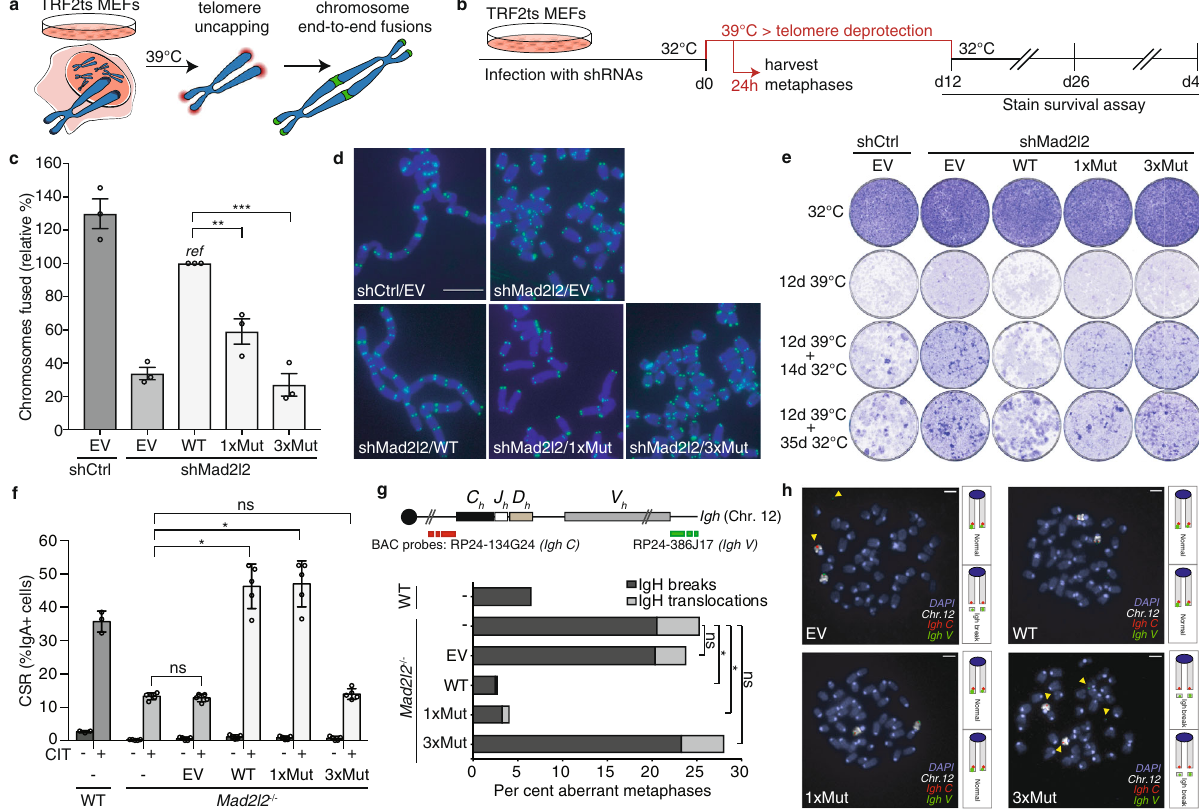
Fig. 2 MAD2L2 dimerization is needed for MAD2L2-mediated control of NHEJ at deprotected telomeres and MAD2L2-mediated class switch recombination. a Experimental approach to address telomere deprotection induced NHEJ. b Schematic overview of the experimental setup used in c – e. c Chromosomal fusions in TRF2ts MEFs transduced with indicated shRNAs and expression constructs ( n = 3 independent experiments, mean ± s.e.m., a minimum of 1500 chromosomes were counted per condition, per experiment). One-way ANOVA with Dunnett ’ s multiple comparisons test (** p = 0.0046; *** p = 0.0002). d Representative images of metaphases counted in c . Scale bar, 10 μ m. e Survival assay of TRF2ts MEFs used in c – d Cells were cultured at 32 °C to exclude toxicity of the infected cells, or at 39 °C for 12 days to induce telomere deprotection. Cells were returned to 32 °C for the indicated times, and stained to assess survival. Plates are representative of n = 2 independent biological duplicates, the second biological duplicate is shown in Supplementary Fig. 1e, f. f CSR defect in Mad2l2 − / − cells is rescued after complementation with WT MAD2L2 and 1xMut but not with 3xMut. Bars represent mean ± s.e.m., two-sided Wilcoxon – Mann – Whitney test. n = 3 independent experiments with one WT clone and two Mad2l2 − / − clones, ns p = 0.6752 (-vs. EV) and p = 0.8340 (-vs. 3xMut); * p = 0.0119. CIT: anti-CD40, IL-4 and TGF- β . g Quanti fi cation of Igh breaks and translocations in metaphases of the indicated WT and Mad2l2 − / − CH12F3 cells. Horizontal bars represent means, two-sided Fisher ’ s exact test; n = 200 metaphases (WT), n = 400 ( Mad2l2 − / − ), n = 384 ( Mad2l2 − / − + EV), n = 400 ( Mad2l2 − / − + WT), n = 400 ( Mad2l2 − / − + 1xMut), n = 357 ( Mad2l2 − / − + 3xMut) from one experiment (WT) or two independent experiments ( Mad2l2 − / − ), ns p = 0.9798 (-vs. EV) and p = 0.9721 (-vs. 3xMut); * p = 0.0146 (-vs. WT) and p = 0.0126 (-vs. 1xMut). h Representative images of Igh breaks in aberrant metaphases in Mad2l2 − / − CH12F3 cells, as quanti fi ed in g . Scale bars, 5 μ